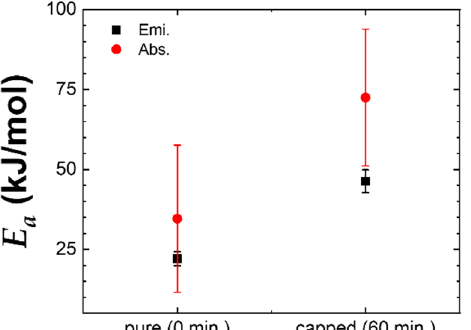
Figure 5. Activation energies obtained through the Arrhenius equation with linear fitting ( lnk vs. 1/T ). Two different spectroscopies (emission and absorption) were performed to obtain E a . The E a values are presented with standard deviations for the pristine and capped QDs. Table 1. Activation energies obtained through in situ emission/absorption spectroscopies depending on the postsynthetic PbSO 4 -oleate capping process. E a from